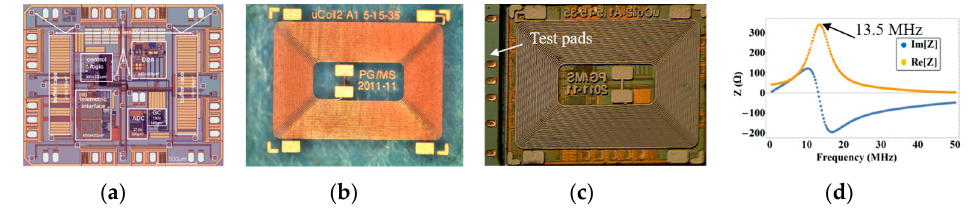
Figure 4. ( a ) Stress-mapping CMOS chip; ( b ) Microcoil with 35 windings; ( c ) Flip-chip assembly; ( d ) Measured assembly input impedance (real and imaginary parts) with resonance peak near 13.56 MHz.